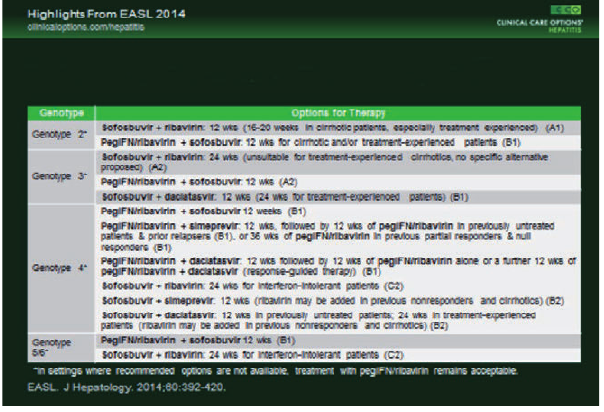
Figure 15. EASL HCV guidelines 2014: Genotype 2-6.